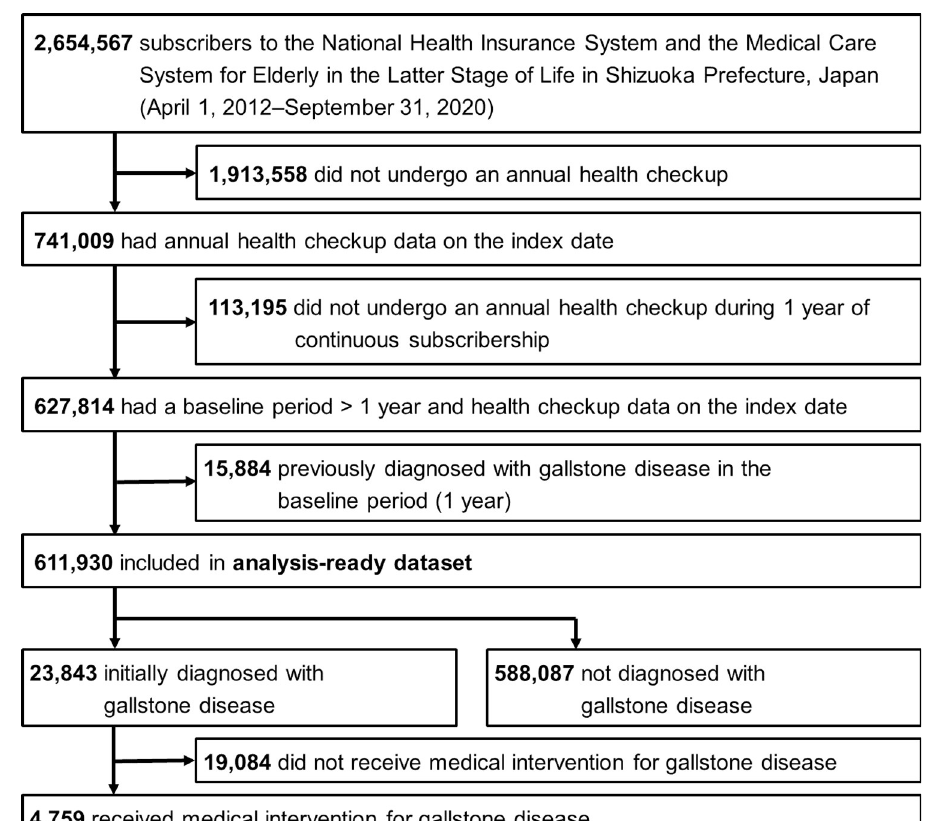
Fig 2. Flow chart of